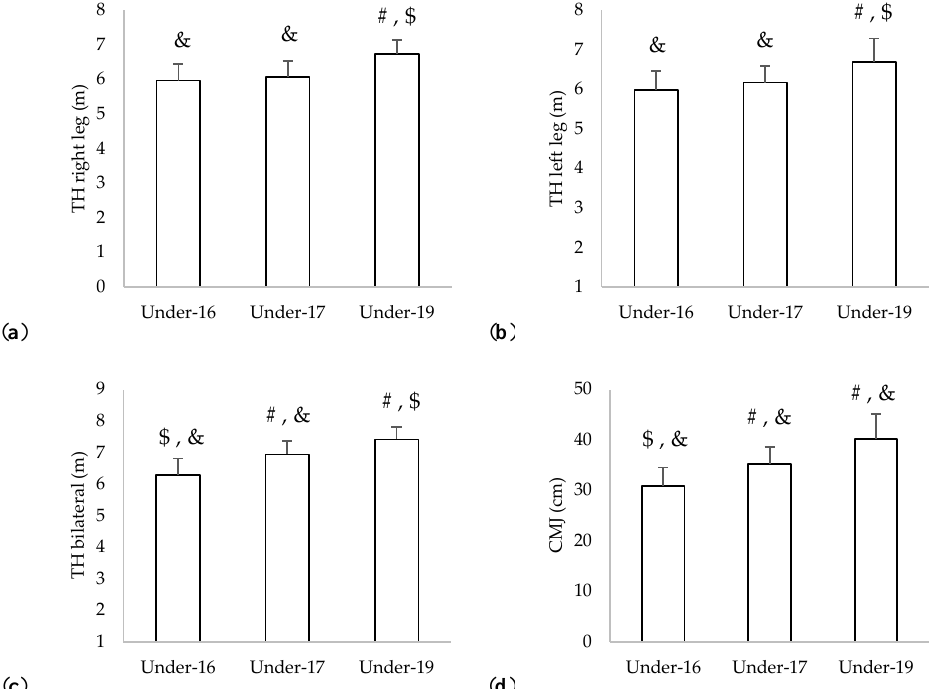
Figure 2. Descriptive statistics (mean and standard deviation) of the ( a ) triple hop right leg and ( b ) triple hop left leg; ( c ) triple hop bilateral; and ( c ) countermovement jump. #: significantly different ( p > 0.05) from under-16; $: significantly different ( p > 0.05) from under-17; &: significantly different ( p > 0.05) from under-19. Descriptive statistics of the YYIRT for each age group can be observed in Figure 3. The under-19 group presented greater average results (491 m). Significant differences between age groups were found in the YYIRT results ( p < 0.001; η 2 =